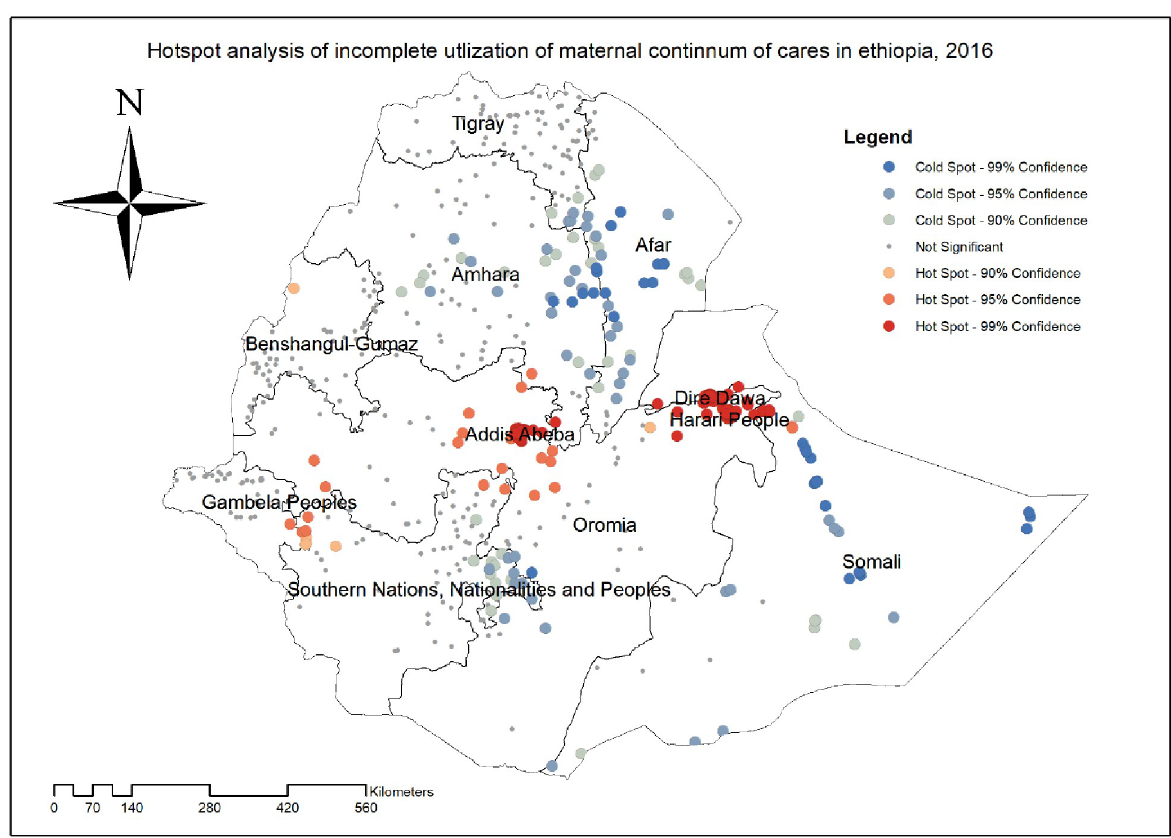
Fig 3. Hot spot analysis of incomplete utilization of maternal continuum of care using Getis Ord Gi � statistics in Ethiopia, produced using Arc GIS version 10.7.